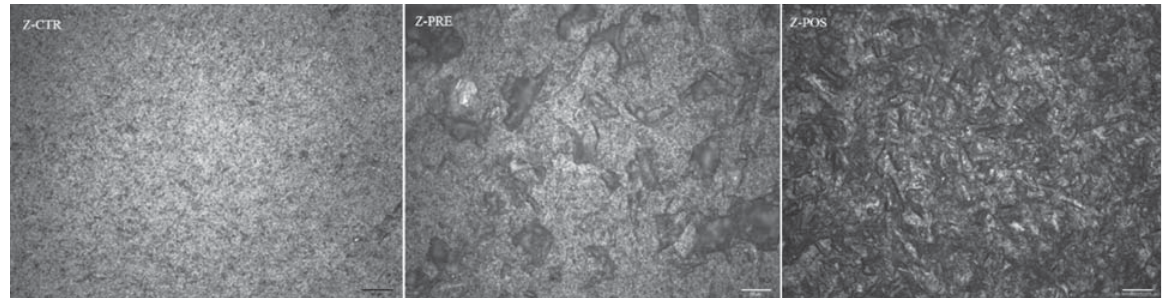
Figure 9- (cid:3)(cid:54)(cid:88)(cid:85)(cid:73)(cid:68)(cid:70)(cid:72)(cid:3)(cid:76)(cid:80)(cid:68)(cid:74)(cid:72)(cid:3)(cid:68)(cid:87)(cid:3)(cid:21)(cid:19)(cid:238)(cid:3)(cid:80)(cid:68)(cid:74)(cid:81)(cid:76)(cid:191)(cid:70)(cid:68)(cid:87)(cid:76)(cid:82)(cid:81)(cid:17)(cid:3)(cid:61)(cid:16)(cid:38)(cid:55)(cid:53)(cid:3)(cid:177)(cid:3)(cid:75)(cid:82)(cid:80)(cid:82)(cid:74)(cid:72)(cid:81)(cid:82)(cid:88)(cid:86)(cid:3)(cid:86)(cid:88)(cid:85)(cid:73)(cid:68)(cid:70)(cid:72)(cid:3)(cid:90)(cid:76)(cid:87)(cid:75)(cid:3)(cid:81)(cid:82)(cid:3)(cid:72)(cid:89)(cid:76)(cid:71)(cid:72)(cid:81)(cid:87)(cid:3)(cid:89)(cid:76)(cid:86)(cid:76)(cid:69)(cid:79)(cid:72)(cid:3)(cid:86)(cid:76)(cid:74)(cid:81)(cid:86)(cid:3)(cid:82)(cid:73)(cid:3)(cid:71)(cid:68)(cid:80)(cid:68)(cid:74)(cid:72)(cid:17)(cid:3)(cid:61)(cid:16)(cid:51)(cid:50)(cid:54)(cid:3)(cid:177)(cid:3)(cid:86)(cid:88)(cid:85)(cid:73)(cid:68)(cid:70)(cid:72)(cid:3) pattern after post-sintering treatment showing irregularities along the surface. Z-PRE – areas of localized irregularities along the surface after pre-sintering treatment